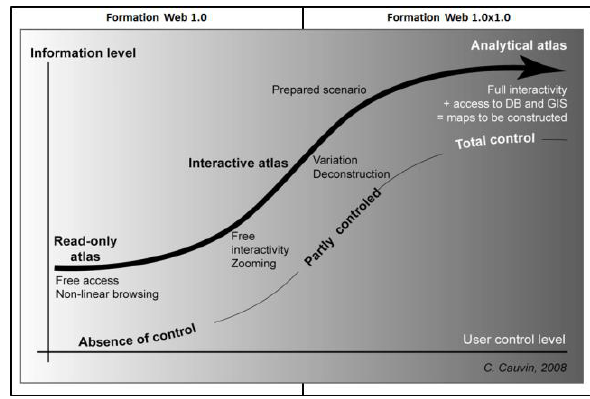
Figure 6. From the view-only atlases to the analytical atlases (Cauvin, et al., 2010; Figure 3.3).